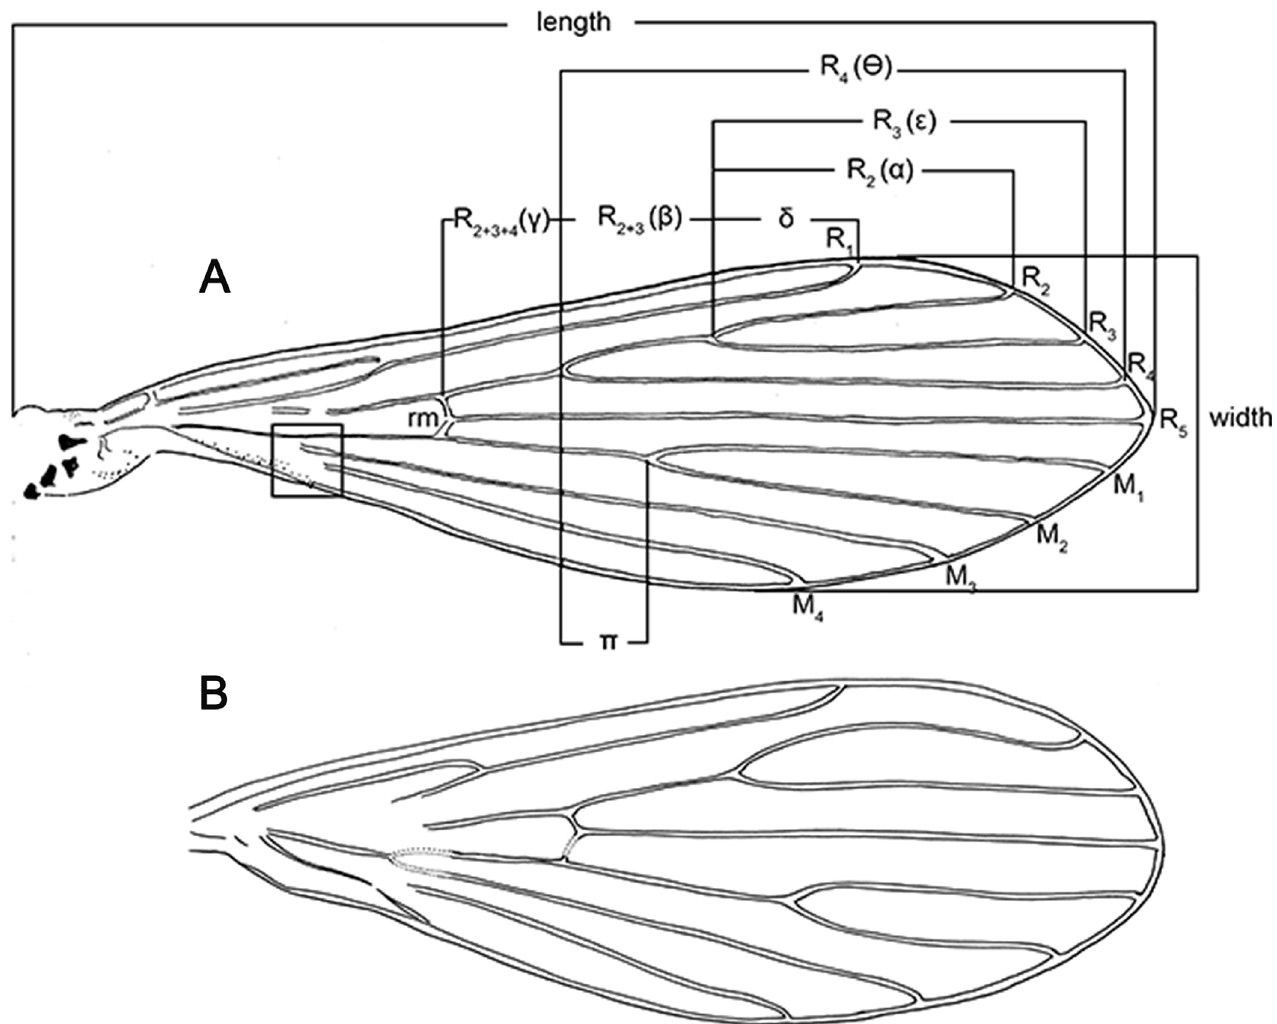
Figure 14. Wing of Phlebotominae. (A) Main indices; (B) wing with of fusion of R2 and R3: Chinius